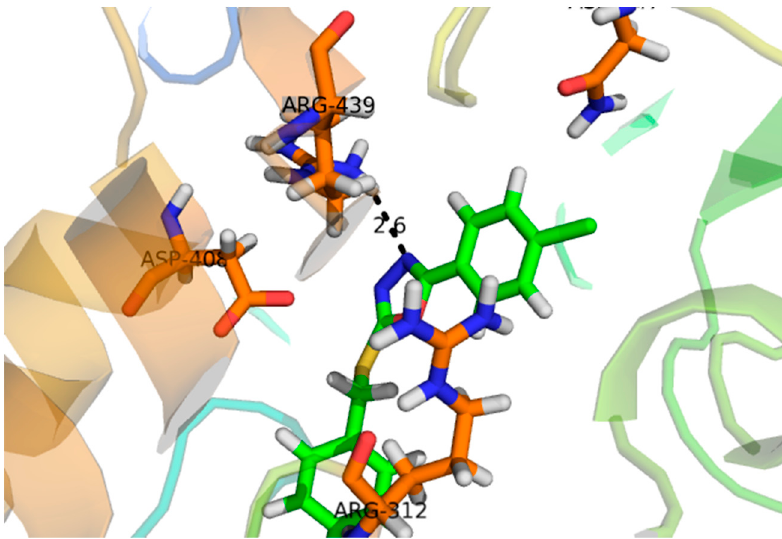
Figure 3. Represents the 3D structures of Compound 1 showing binding potential. Red color in the image shows position of oxygen, green benzene ring, white hydrogen atom, brown color indicates amino acid sequence and blue color indicate nitrogen or amino group.